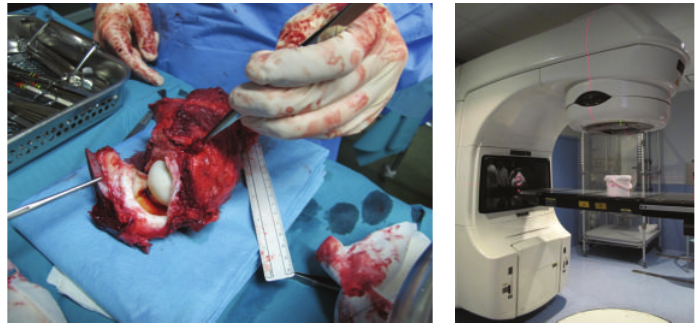
Figure 2: Following the Bernese periacetabular osteotomy, an en bloc extra-articular resection of the acetabulum was performed; the resected specimen was then transferred to a separate sterile trolley. A capsulectomy was made through the acetabular rim, and the articular fluid and proximal femur were sent for histological examination. The acetabulum was placed in a sterile container and sent to the radiotherapy department for extracorporeal irradiation.